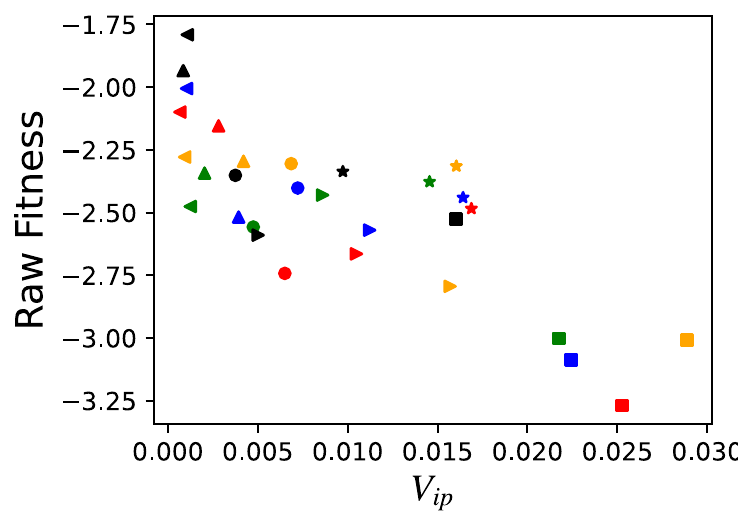
Fig 8. Trade-off between phenotypic variation ( V ip ) and fitness. Trade-off between isogenic phenotypic variation P l out ( V ip ) of the output genes and raw fitness . Each value is computed by the average from 2500–3000 generations. x i i ¼ 1 Each color represents a different interaction strength: c = 0 (black), c = 1 (green), c = 2 (red), c = 3 (blue), and c = 4 (yellow). Each marker shape represents a different noise strength: σ = 0.05( � ), σ = 0.04( ? ), σ = 0.03( ⊳ ), σ = 0.02( � ), σ = 0.01( 4 ), and σ = 0.001( ⊲ ).